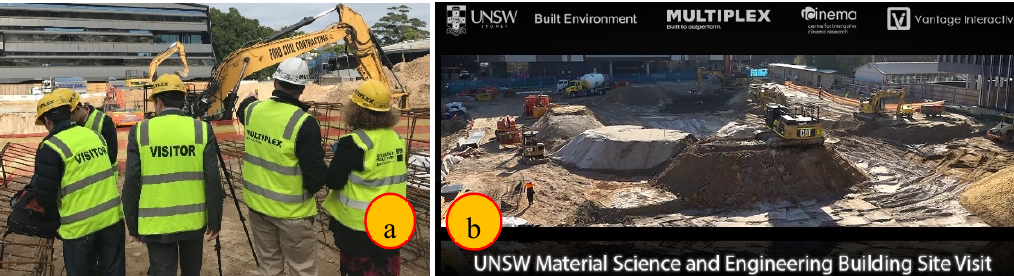
Figure 6. Leading a team of internal and external parties for developing the modules from fieldwork to digital lab production. ( a ) fieldwork for production planning in 2017; and ( b ) capturing 360 footages, including some patterns’ logo involved in the production.